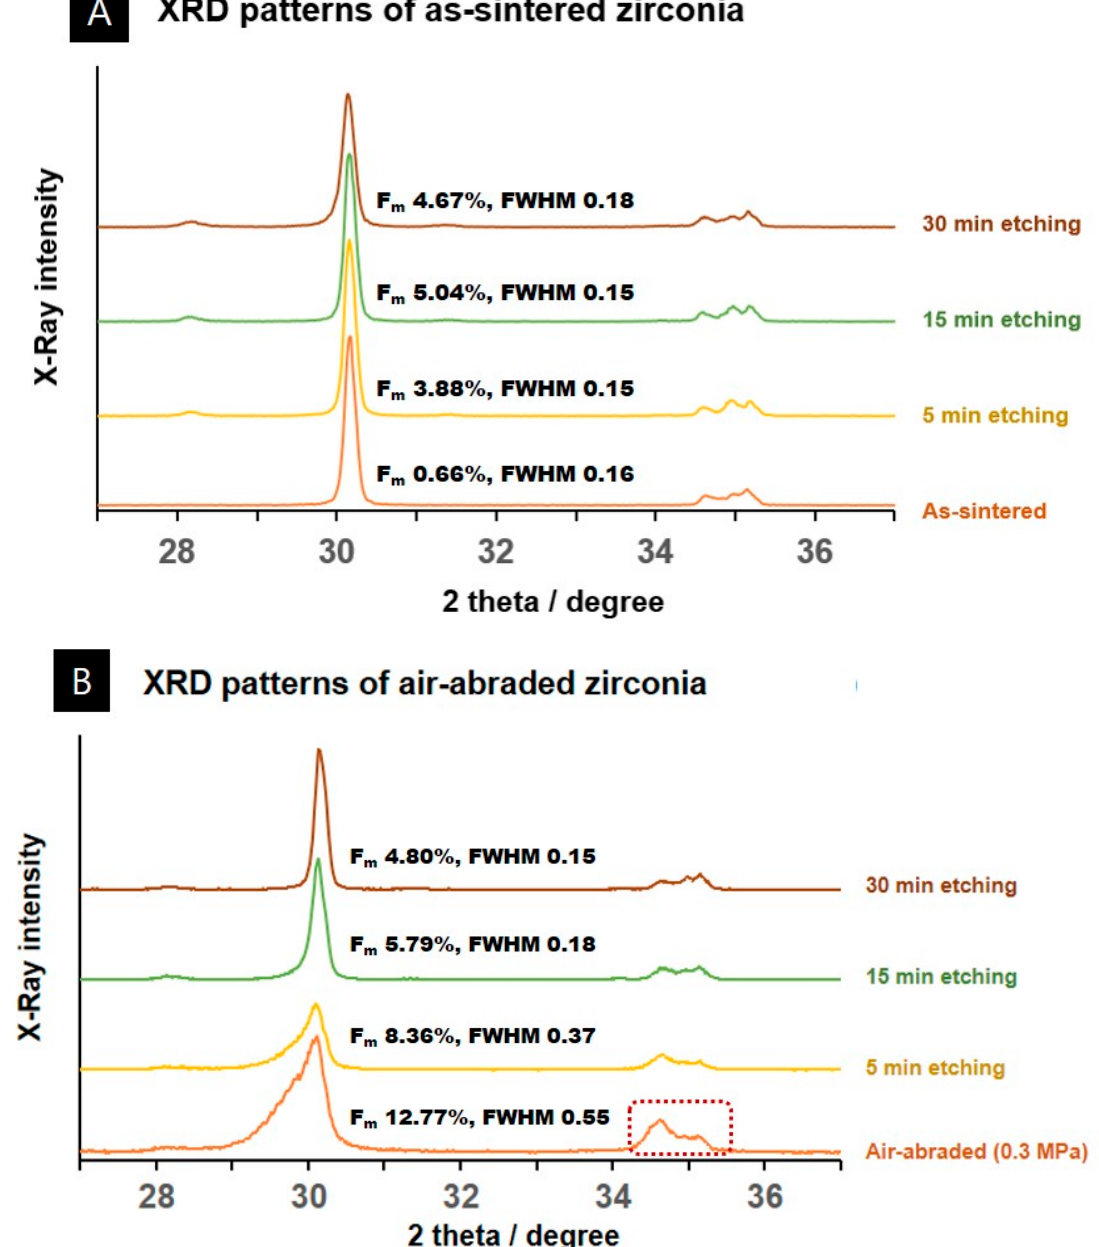
Figure 3. XRD patterns of as-sintered and air-abraded zirconia specimens. ( A ) As-sintered zirconia group. A slight increase in the monoclinic phase was visible; FWHM did not show a significant change. ( B ) Air-abraded zirconia group. Immediately after air-abrasion treatment, an increase of monoclinic phase was seen (orange colored line); an increase in the FWHM and reversed intensity of peaks (002) t and (110) t in the region of 2 θ = 30° were observed (red dotted box). However, as the etching time increased, the monoclinic phase and FWHM decreased, and the reversed intensity of peaks also disappeared. Table 2. Monoclinic phase contents of the as-sintered and air-abraded zirconia samples in accord- ance with etching time. In as-sinter zirconia, the value slightly increased as the etching time in- creased, and in air-abraded zirconia, the value increased rapidly after air-abrasion, and then grad- ually decreased as the etching time increased.